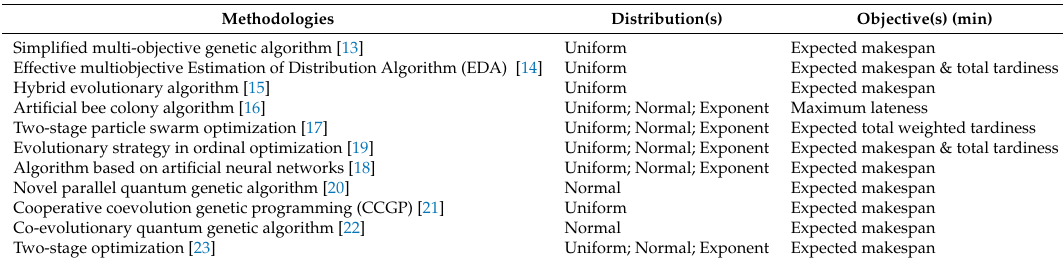
Table 1. A summary of the fuzzy models, objectives and